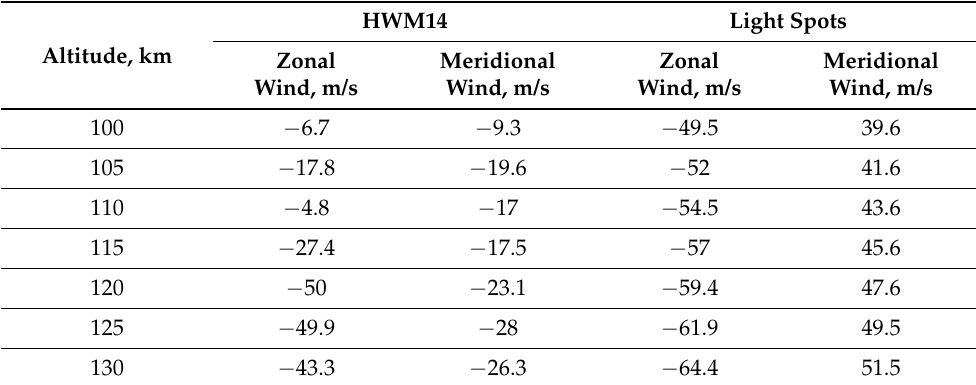
Table 1. Comparison of zonal and meridional winds according to different data. HWM14 Light Spots Altitude, km Zonal Wind, m/s